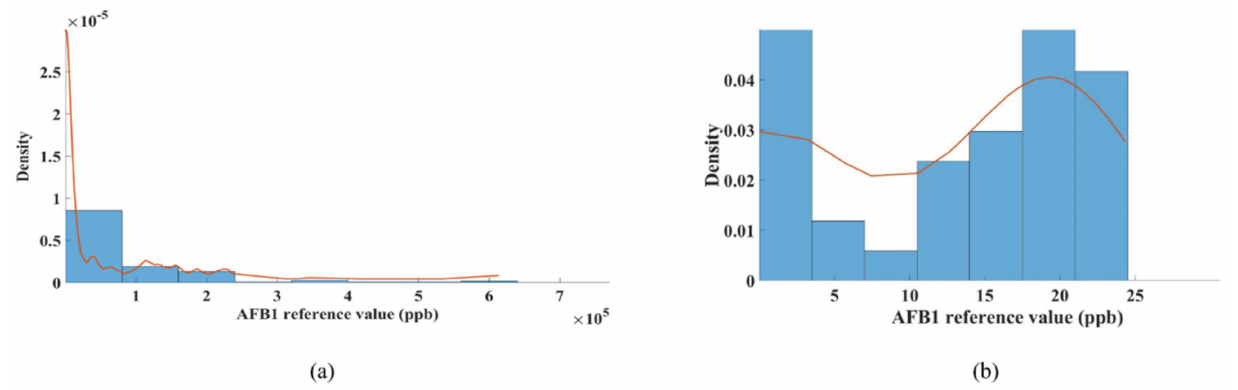
Figure 3. Distribution statistics ( a ) of AFB 1 in peanut samples and after Box-Cox transformation ( b ).